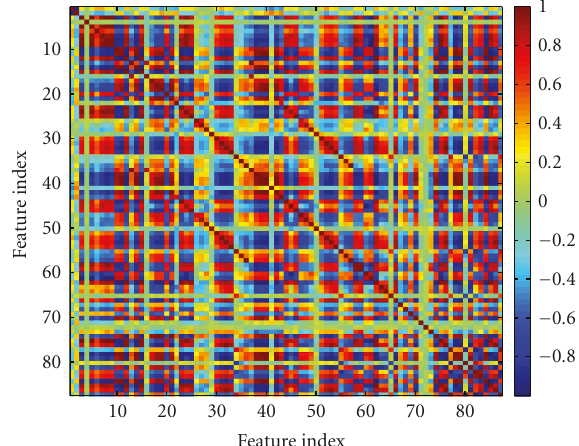
Figure 5: Correlation matrix for a normal sample.